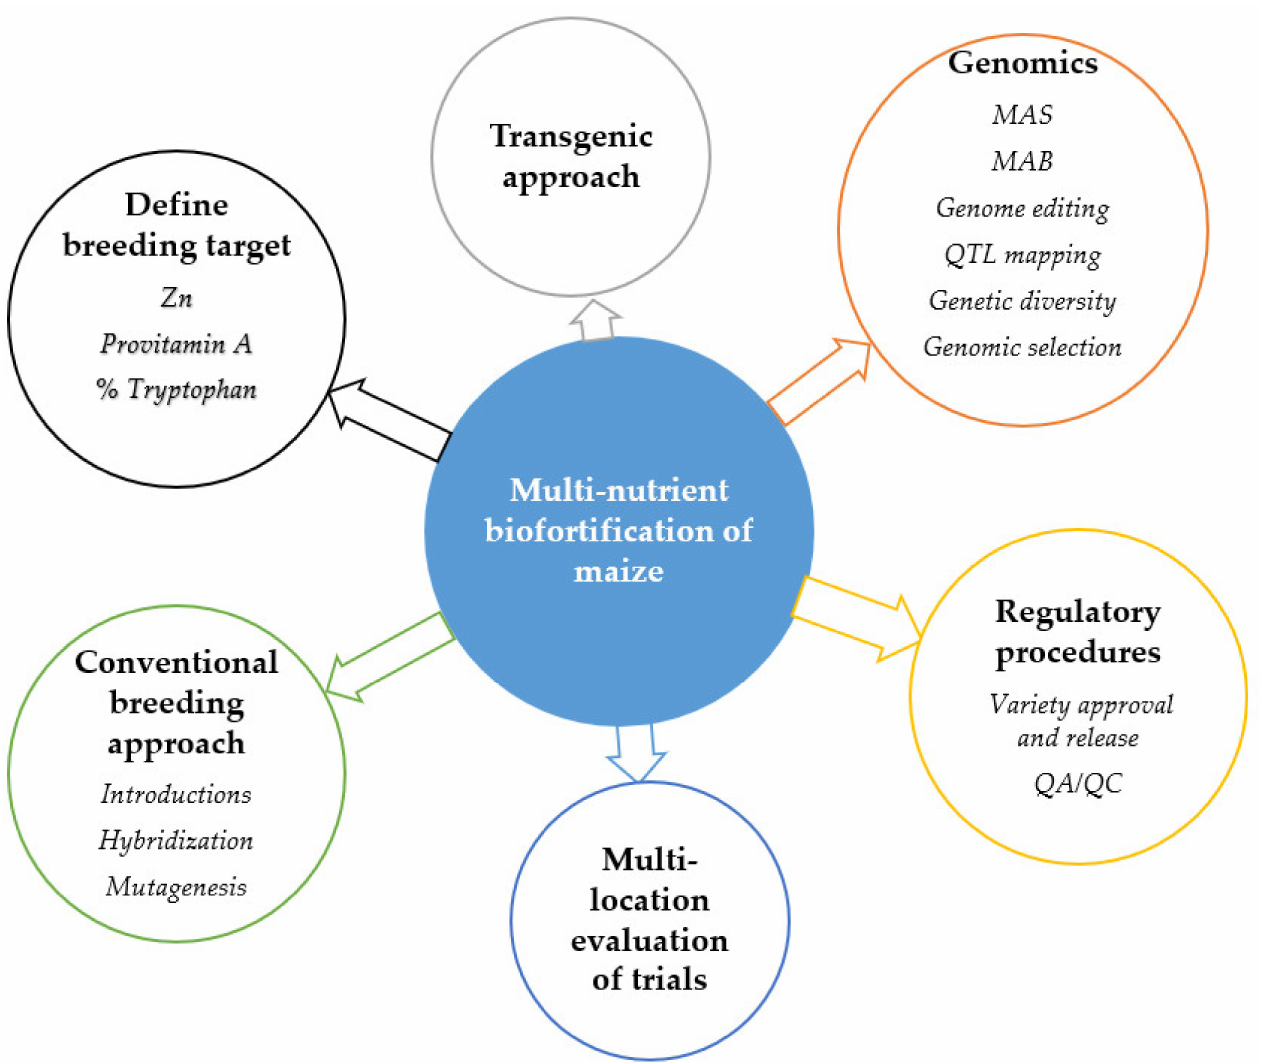
Figure 2. Breeding strategies that can be used for the development of multinutrient maize genotypes. MAS = marker-assisted selection, MAB = marker-assisted backcrossing, QA = quality assurance, QC = Quality